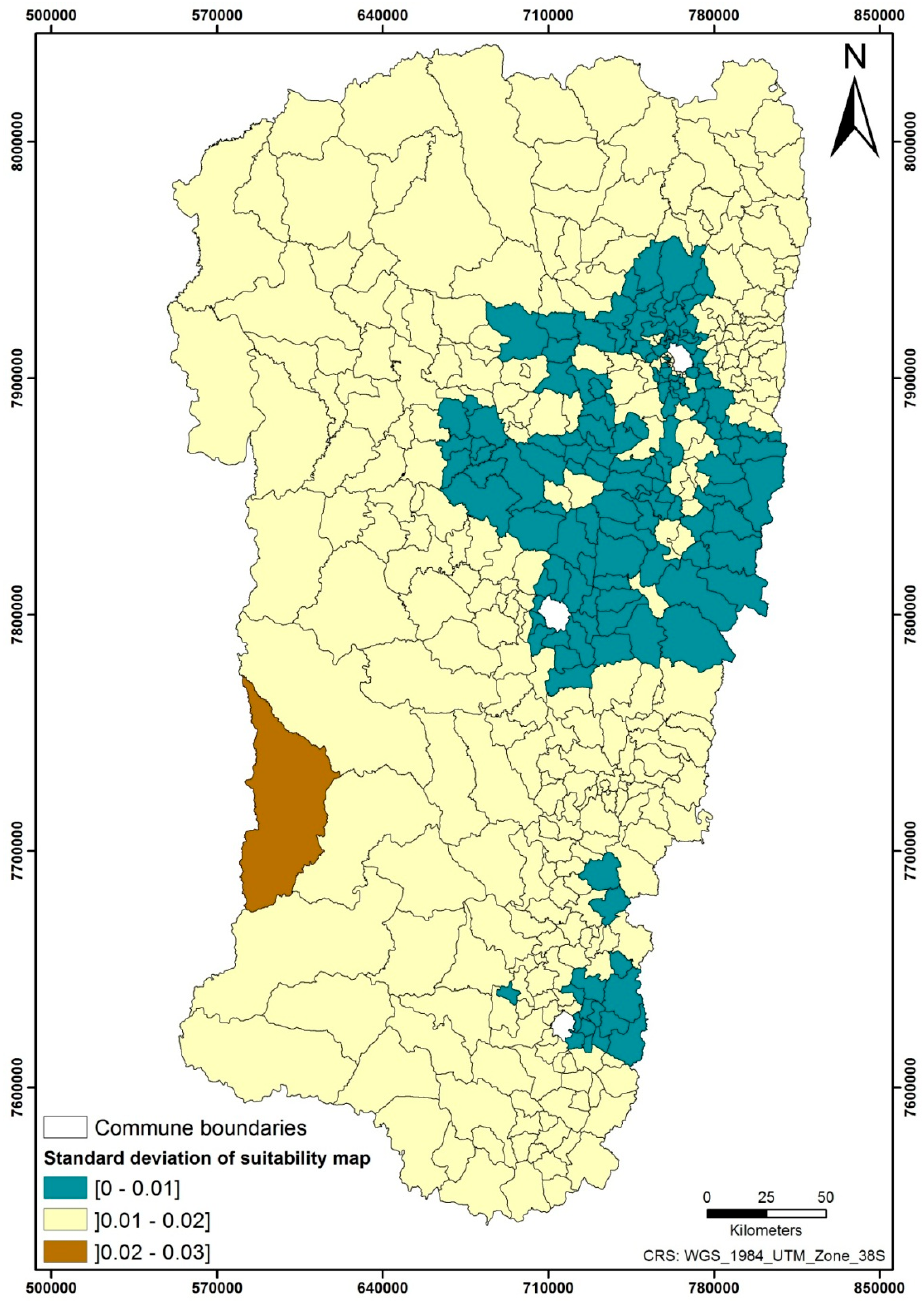
Figure 6. Uncertainty map.